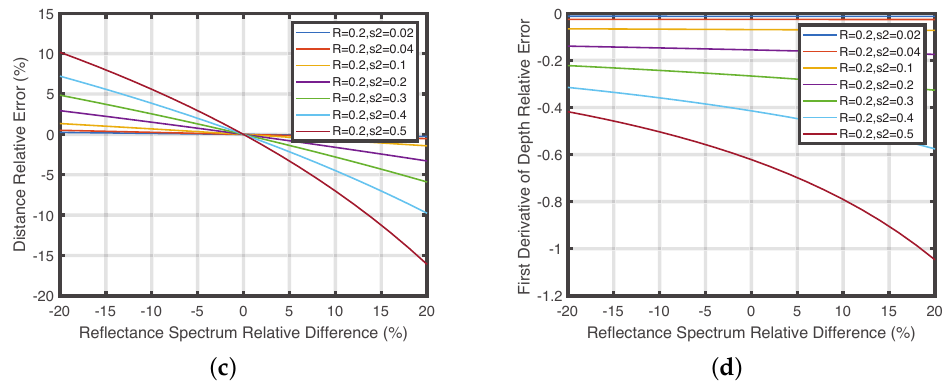
Figure 4. Distance relative error with respect to the reflectance spectrum relative difference. ( a ) Distance relative error when s 2 is fixed. ( b ) First derivative of ( a ). ( c ) Distance relative error when R is fixed. ( d ) First derivative of ( c